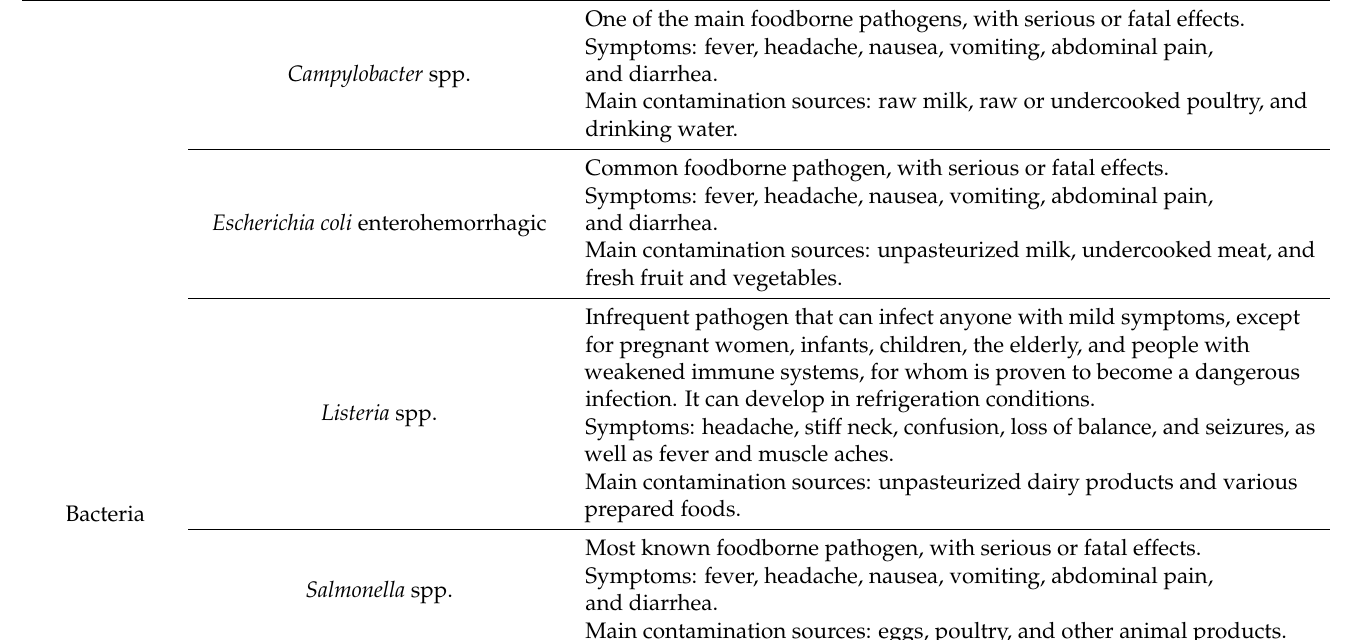
Table 1. Leading causes of foodborne illness